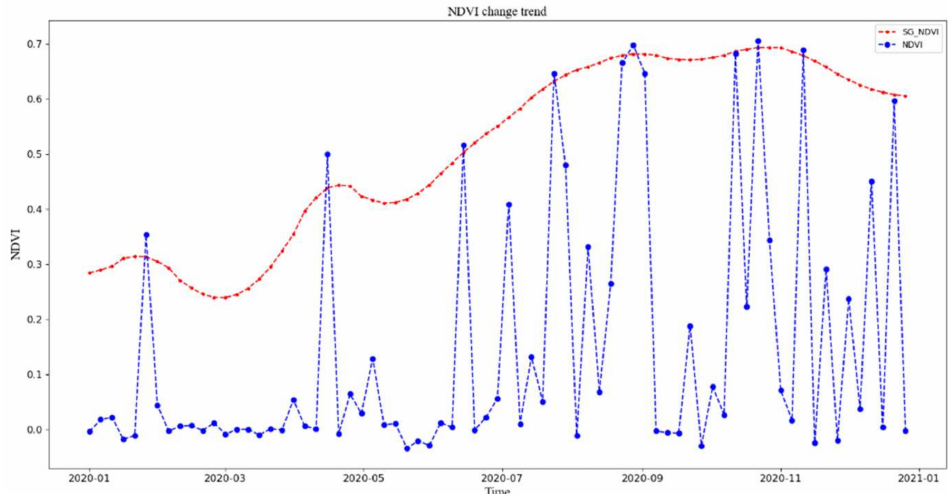
Figure 2. NDVI values before and after